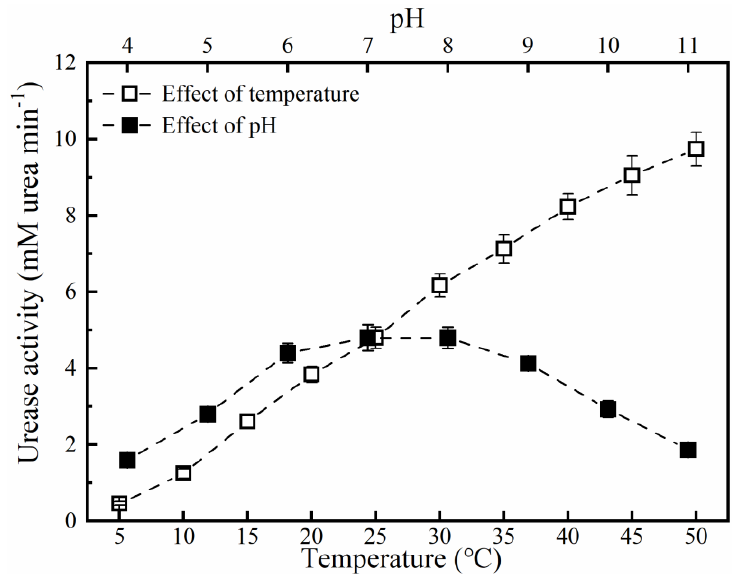
Figure 3. Effect of temperature and pH on the enzyme activity of soybean crude urease. Table 1. Properties of sand used in this study.